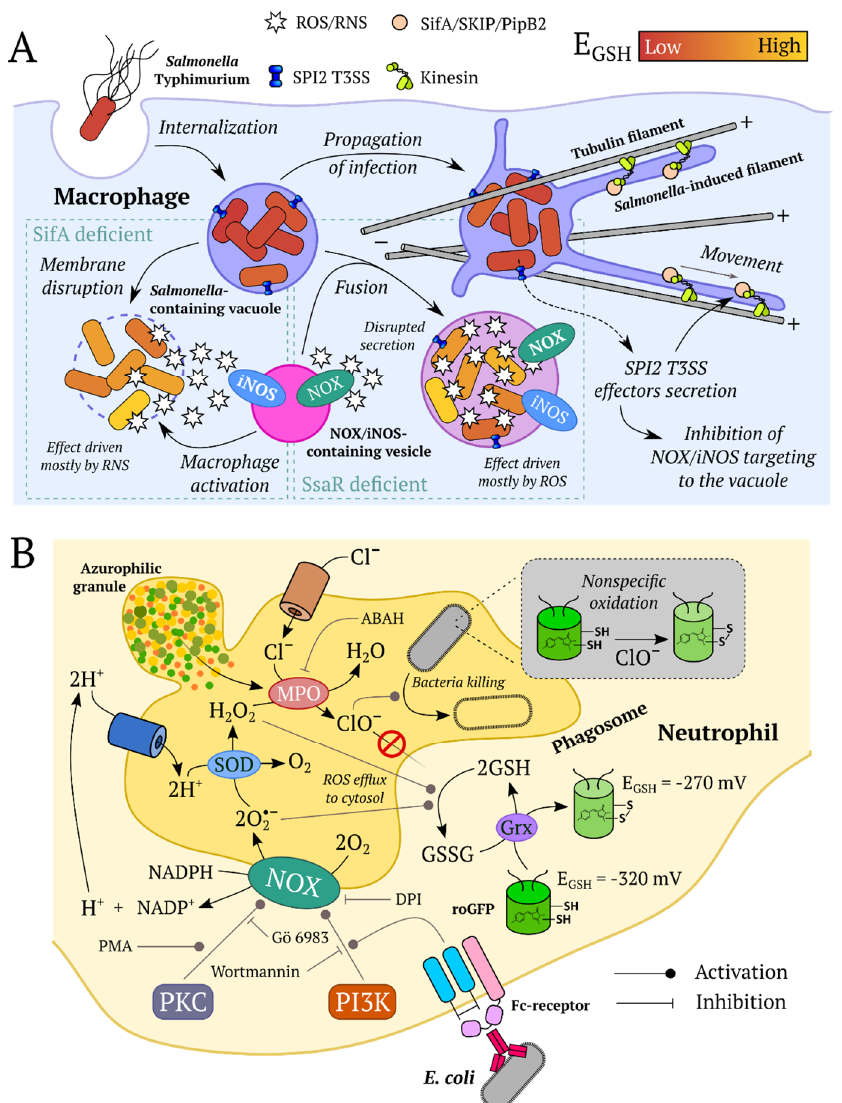
Figure 8. The picture represents selected redox processes during bacteria and immune cells interactions. ( A ) When residing in macrophages, Salmonella Typhimurium is capable of avoiding redox stress due to injection of Salmonella pathogenicity island 2 (SPI2) effectors via type 3 secretion system (T3SS) into the host cytosol. These proteins disrupt the correct localization of reactive oxygen/nitrogen species (ROS/RNS) generating machinery [259]. ( B ) Any implementation of roGFP-based probes in neutrophilic phagosome faces significant di ffi culties since high